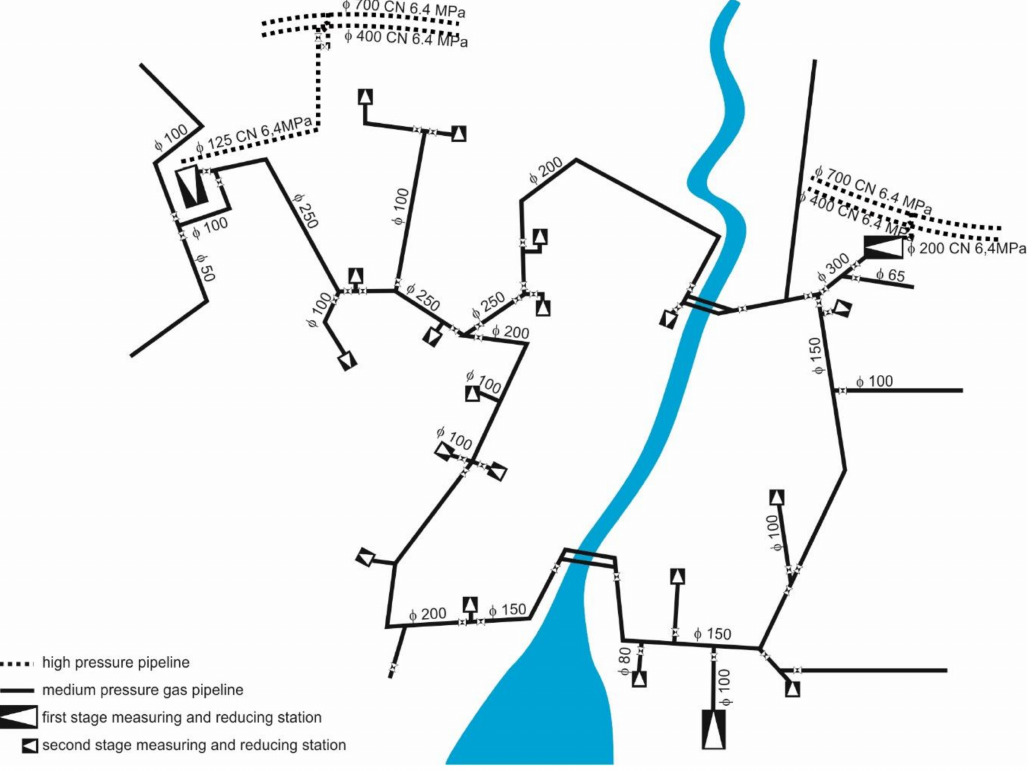
Figure 5. Schematic depiction of the gas network in the distinguished city on the basis of Tch ó rzewska-Cie´slak